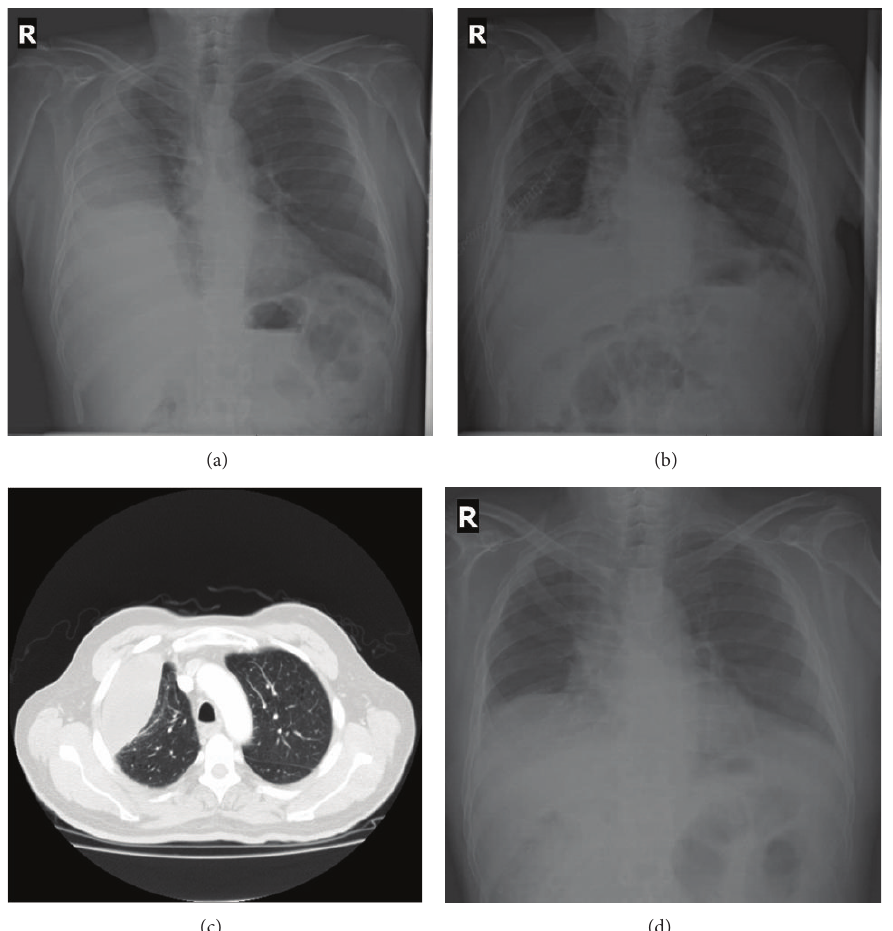
Figure 1: Posteroanterior chest X-ray in admission (a), after catheter thoracostomy (b) and thorax tomography (c), and posteroanterior chest X-ray after steroid treatment